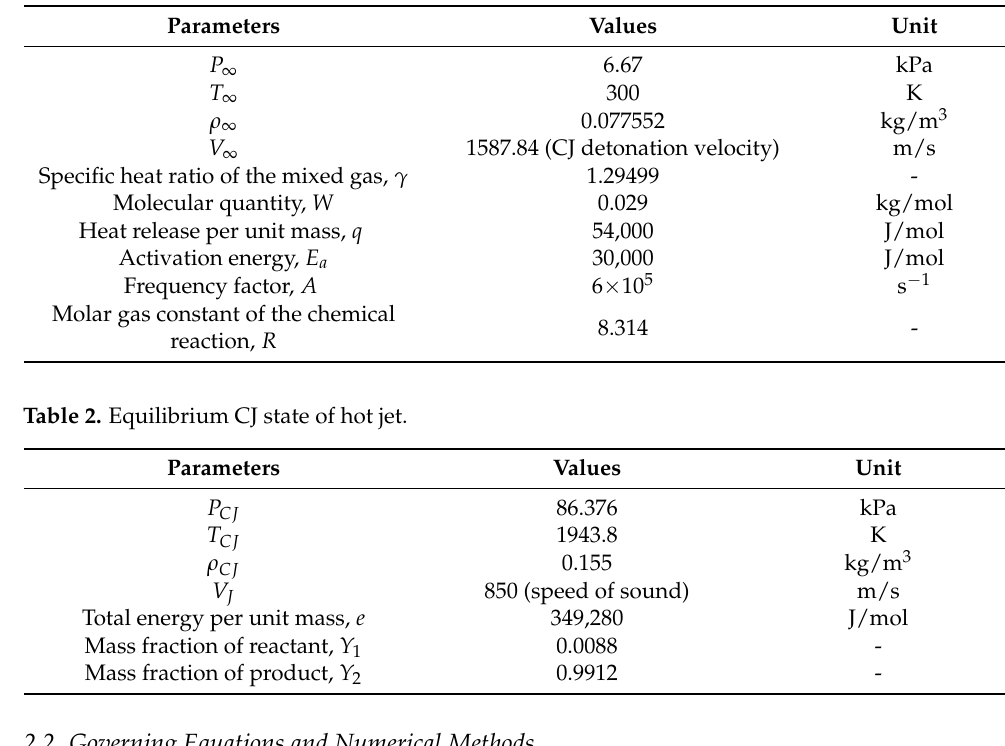
Table 1. Basic inflow parameters.